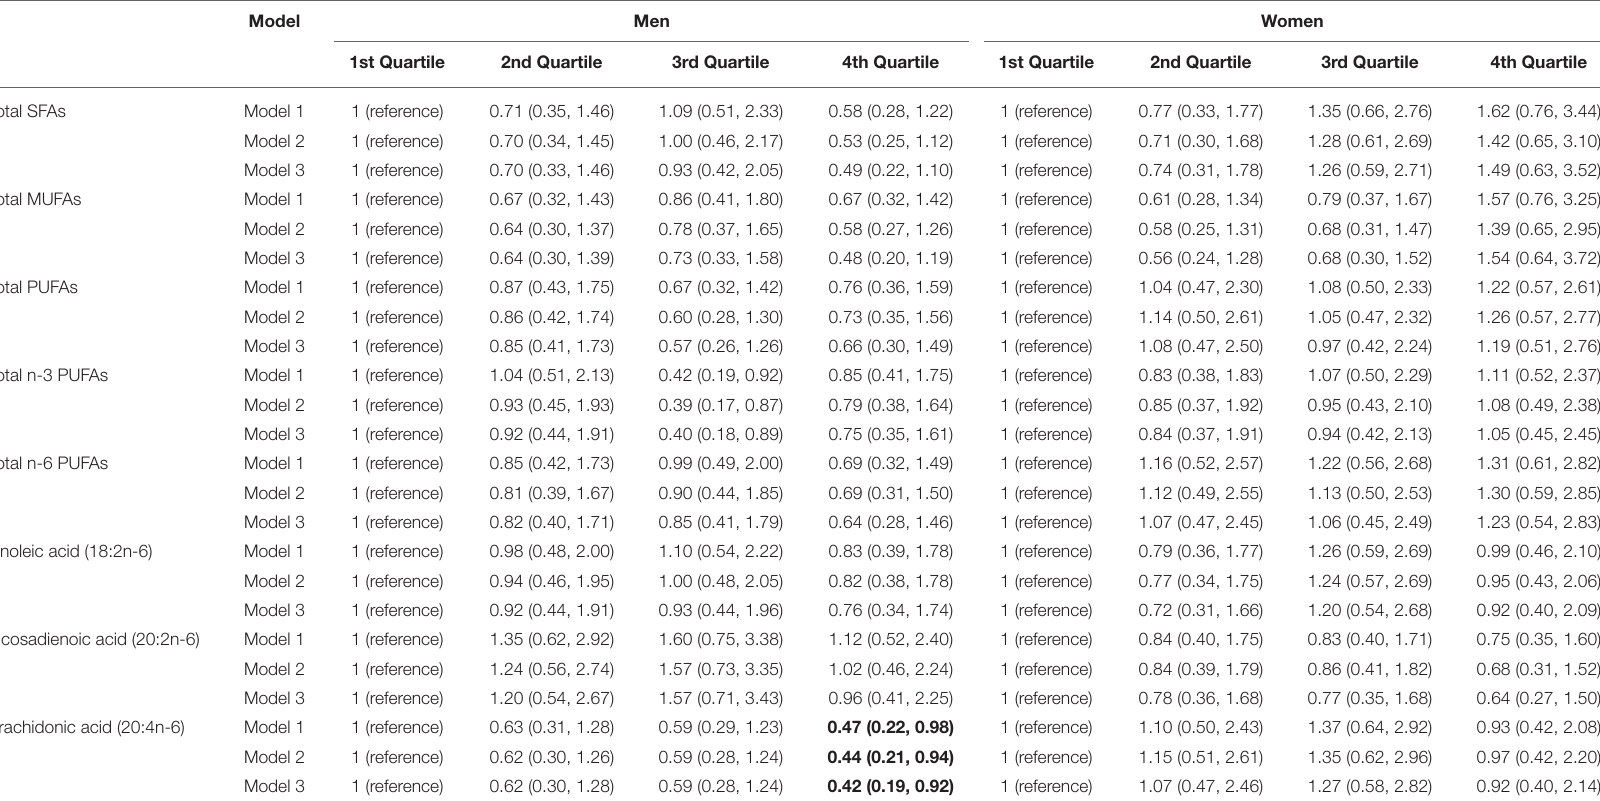
Values are ORs (95% CIs) by quartile unless otherwise indicated. SFA, saturated fatty acid; MUFA, monounsaturated fatty acids; PUFA, polyunsaturated fatty acid. Model 1: adjusted for age; Model 2: Adjusted for Model 1 + smoking status, alcohol status and BMI; Model 3: Adjusted for Model 2 + hypertension and dyslipidaemia. The bold values mean the results are